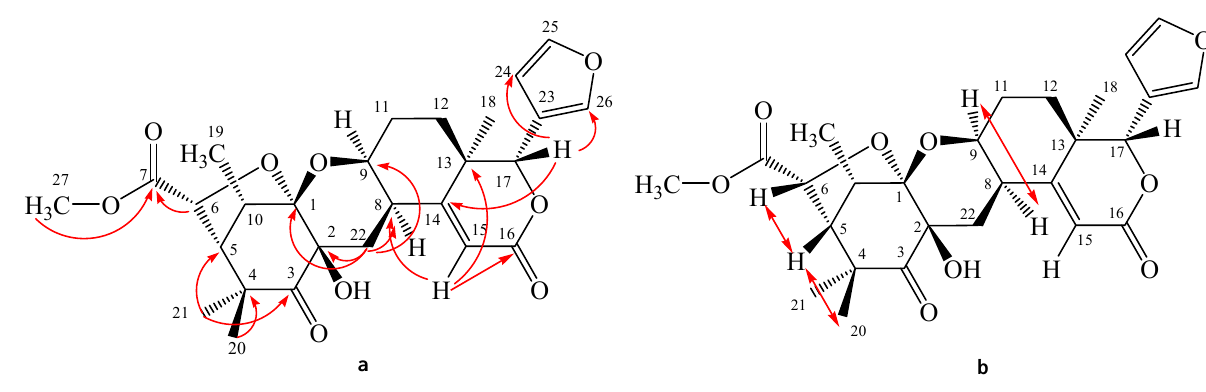
Figure 2. Selected HMBC (H → C) ( a ) and NOESY ( ↔ ) ( b ) correlations of kokosanolide